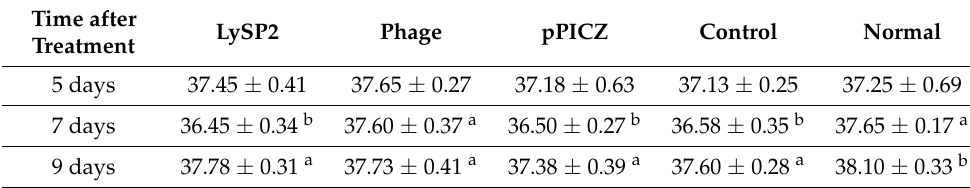
Table 4. Chick body temperature ( ◦ C) after